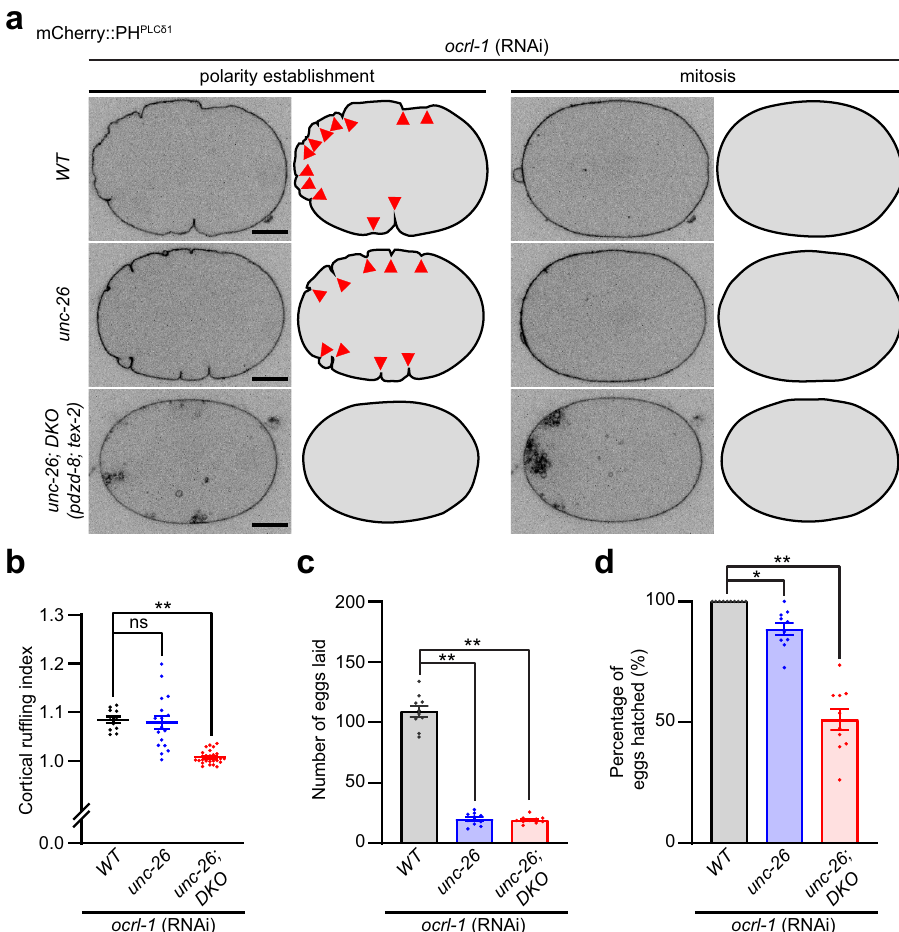
Fig. 5 Simultaneous depletion of PDZD-8, TEX-2, and PI(4,5)P 2 phosphatases results in reduced cortical ruf fl ing and embryonic lethality. a Representative live spinning disc confocal (SDC) images of equatorial planes of early embryos from OCRL-1 RNAi-treated wild-type control (WT) animals, OCRL-1 RNAi-treated unc-26 mutants and OCRL-1 RNAi-treated unc-26; double knock-out [DKO (pdzd-8; tex-2) ] mutants, expressing PI(4,5)P 2 biosensor (mCherry::PH PLC δ 1 ). Images of each row are from time-lapse movies of the same embryos at different phases as indicated. Cartoons depicting the outline of the embryos. Red arrowheads indicate cortical ruf fl ing. Note the loss of cortical ruf fl ing in OCRL-1 RNAi-treated unc-26 ; DKO mutants, during the polarity establishment phase. Scale bars, 10 μ m. b Quanti fi cation of cortical ruf fl ing. The cortical ruf fl ing index was calculated by taking the ratio of the perimeter of the plasma membrane of embryos from polarity establishment phase and mitosis phase, as assessed in ( a ) (see Methods) [mean ± SEM, n = 11 embryos (WT ; ocrl-1 RNAi), n = 17 embryos ( unc-26; ocrl-1 RNAi), n = 26 embryos ( unc-26; DKO ; ocrl-1 RNAi); Dunnett ’ s multiple comparisons test, ** p < 0.0001 ( unc-26; DKO ; ocrl-1 RNAi), ns denotes not signi fi cant]. c Quanti fi cation of the number of eggs laid by OCRL-1 RNAi-treated WT animals, OCRL-1 RNAi- treated unc-26 mutants and OCRL-1 RNAi-treated unc-26; DKO mutants [mean ± SEM, n = 10 animals for all conditions; Dunnett ’ s multiple comparisons test, ** p < 0.0001 ( unc-26; ocrl-1 RNAi), ** p < 0.0001 ( unc-26; DKO ; ocrl-1 RNAi)]. d Quanti fi cation of the percentage of eggs successfully hatched in indicated conditions as in ( c ) [mean ± SEM, n = 10 animals for all conditions; Dunnett ’ s multiple comparisons test, * p = 0.0182 ( unc-26; ocrl-1 RNAi), ** p < 0.0001 ( unc-26; DKO ; ocrl-1 endogenous expression levels. The ER marker, GFP::C34B2.10, frequently wrapped around late endosomes that were marked by mCherry::RAB-7, supporting the occurrence of ER-late endosome contacts in early embryos (Fig. 6a). Remarkably, distinct PDZD-8::mNeonGreen puncta were present on a small fraction of mCherry::RAB-7-positive late endosomes (Fig. 6b). The association was often transient, with the longest association lasting up to 45 s during the imaging period (Fig. 6c and Supplementary Movie 6). Because PDZD-8::mNeonGreen loca- lizes to the ER (Supplementary Fig. 6b), these results support the presence of PDZD-8 at ER-late endosome contacts. In contrast, TEX-2::EGFP showed no particular association with mCher- ry::RAB-7-positive late endosomes in early embryos, consistent with the results obtained from the COS-7 cells (Supplementary Fig. 6e).